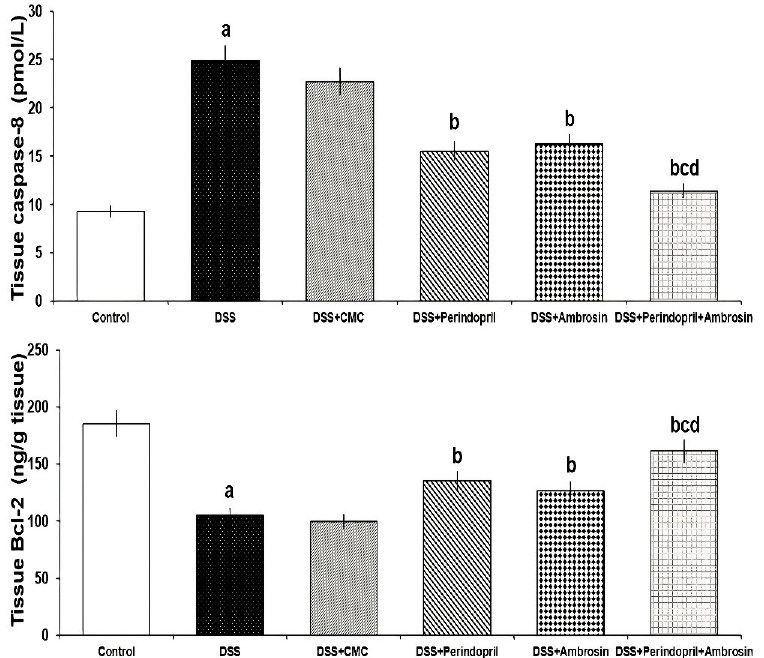
Figure 4. Effect of perindopril with or without ambrosin on caspase-8 and Bcl-2 levels in the colonic tissues of DSS-treated mice (Mean ± SD); where “a” denotes significant vs the control group ( p -value less than 0.05); “b” denotes significant vs DSS group ( p -value less than 0.05); “c” denotes significant vs DSS + perindopril group ( p -value less than 0.05); “d” denotes significant vs DSS + ambrosin group ( p -value less than 0.05).